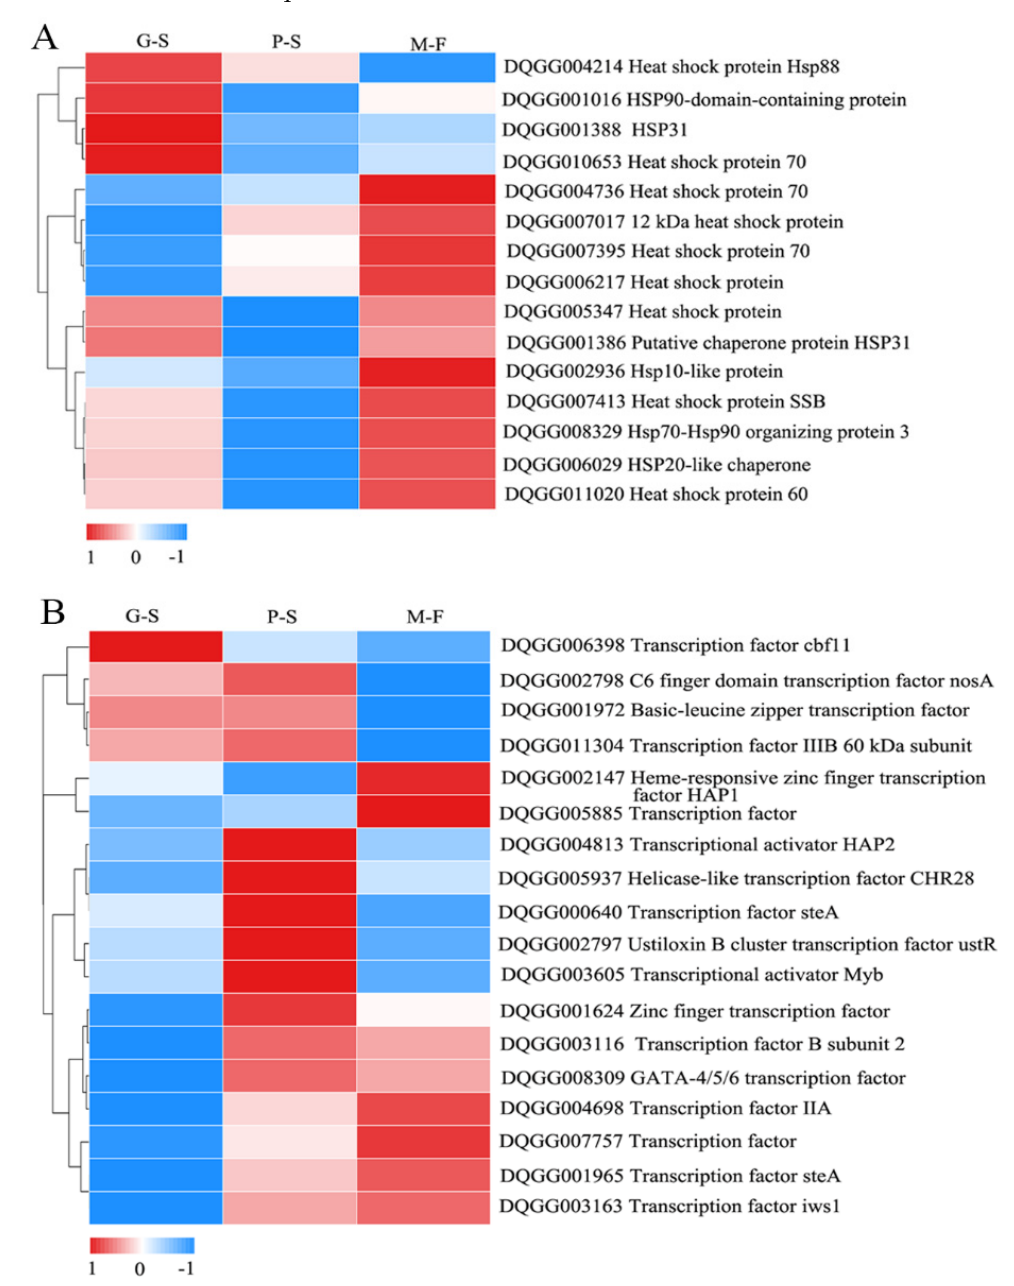
Figure 6. Heatmap analysis of the expression patterns of heat shock proteins and transcription factors: ( A ) differential expression of heat shock proteins in response to temperature changes; ( B ) differential expression of transcription factors during growth and development. The expression levels are represented by log 2 (FPKM + 1) values after centralization correction. Genes with similar patterns of expression are clustered together.